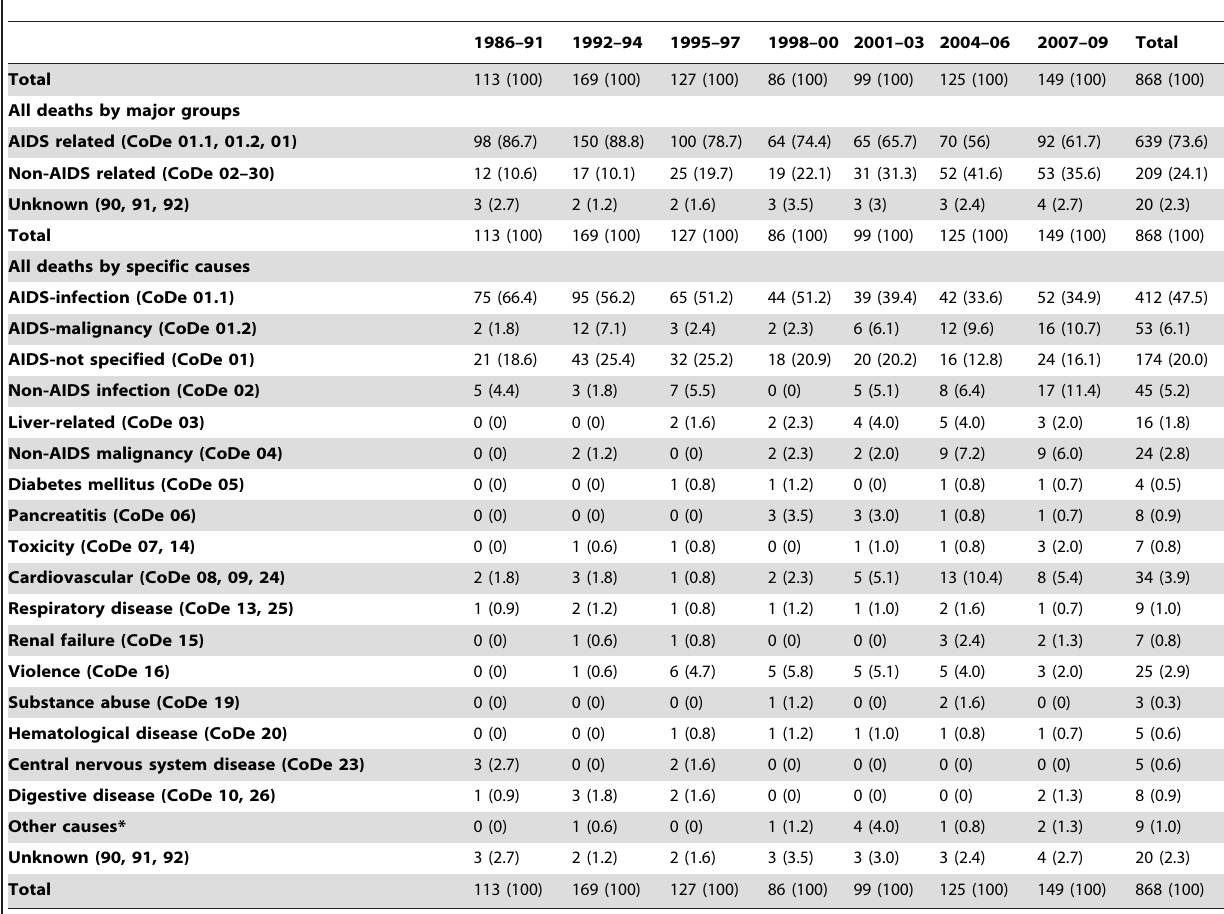
Table 2. Number (percent) of causes of death overall, AIDS and non-AIDS related and by specific causes by calendar